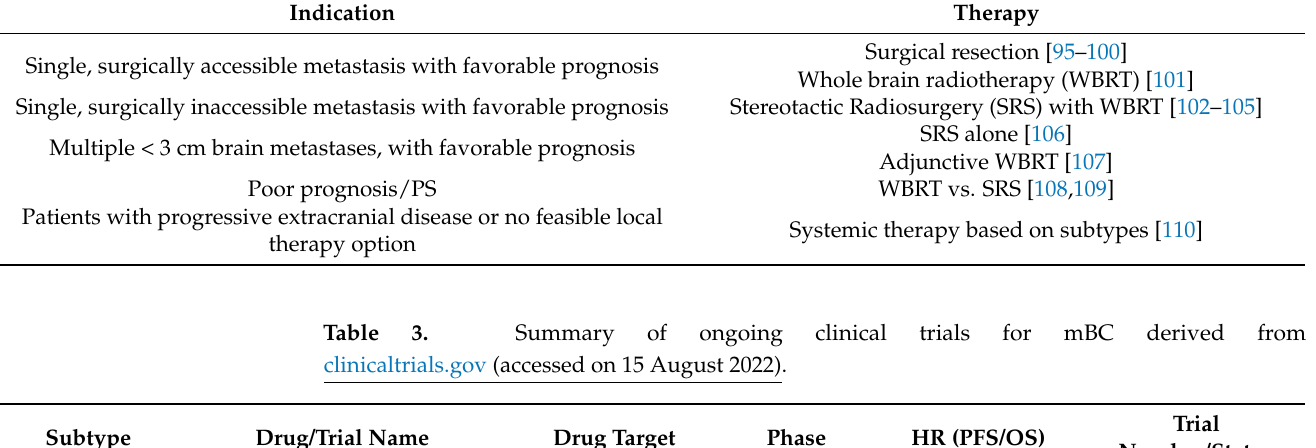
Table 2. Summary of Brain Metastasis Treatment.